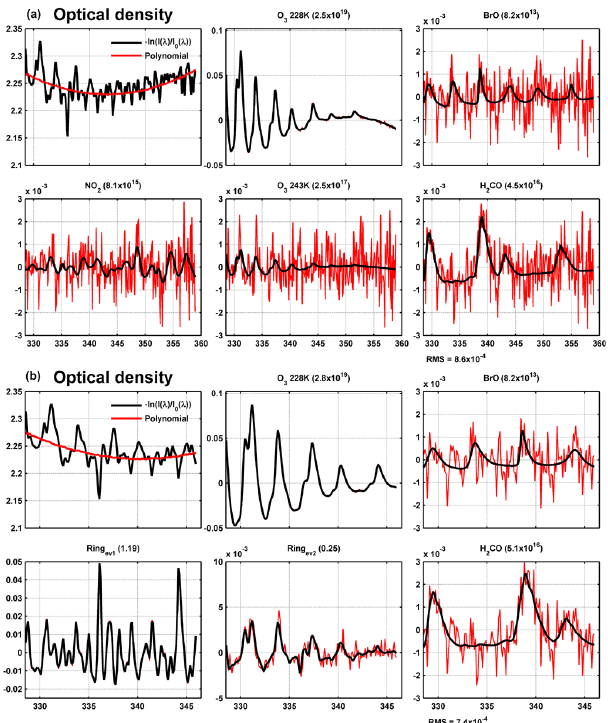
Fig. 4. Illustration of the 2-step DOAS fit of a GOME-2 spectrum overpassing a region of large biogenic emissions in southeastern US (9 August 2007, orbit 4176, SZA: 28 ◦ ). (a) First step in the wave- length interval 328.5–359nm, (b) second step in the wavelength interval 328.5–346nm. The BrO slant column is not fitted in the second step. Each plot shows the optical density in black [no unit] and the residuals in red. The fitted slant columns are given above [molec.cm − 2 ]. The root mean square of the fit (RMS) in each wave- length interval is given at the bottom of the figure [no